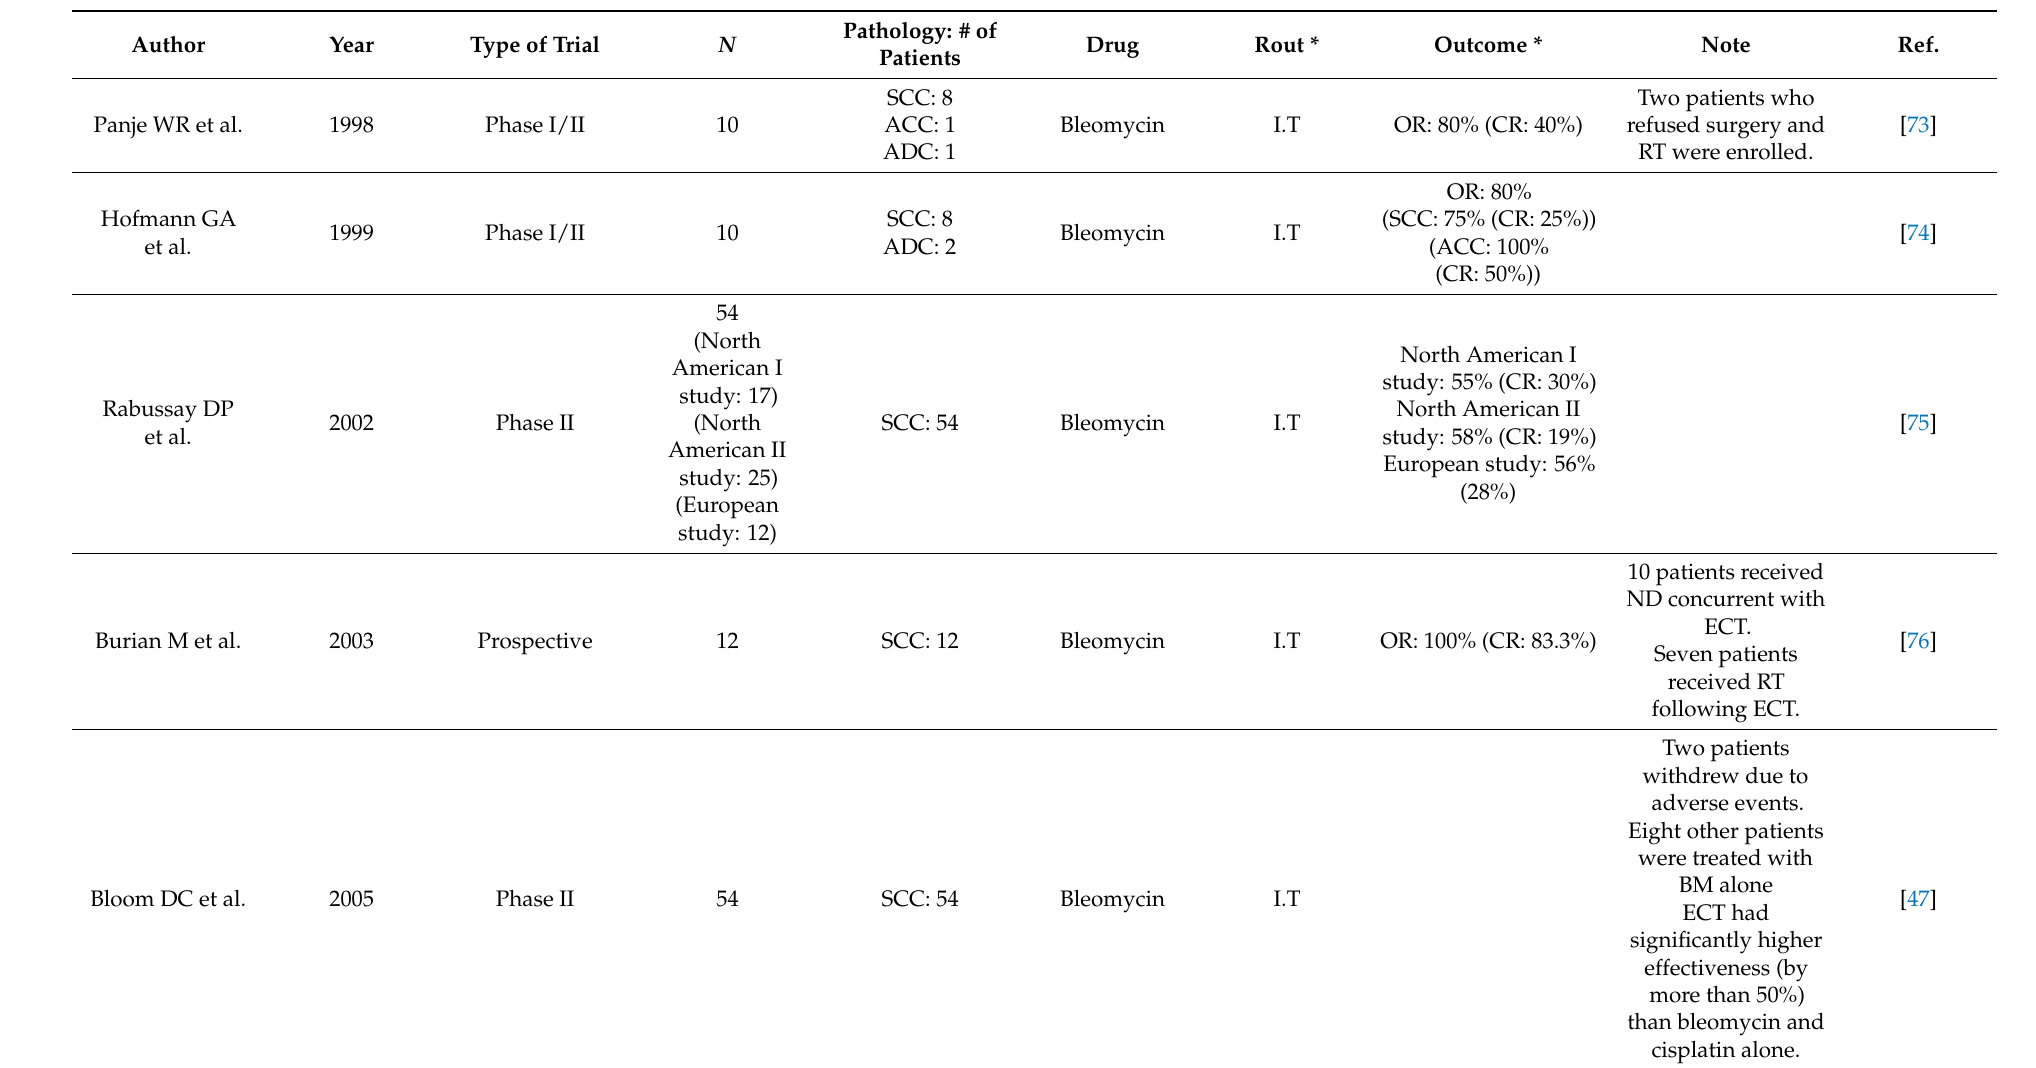
Table 1. The studies of Electrochemotherapy in Head and Neck